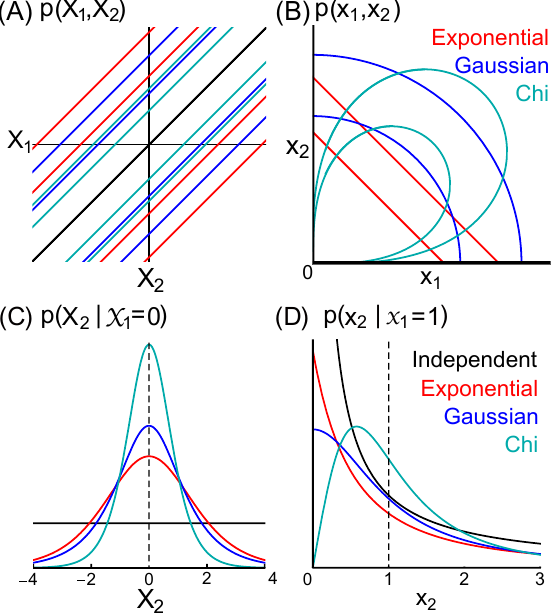
Figure 2. Exemplary distributions for exponential (red), Gaussian (blue), and chi (cyan) dependencies. ( A ) Equiprobability contours of p ( X 1 , X 2 ) , which we prove are parallel to the identity line for all dis- tributions in set S (Equation (29)). ( B ) Contours of p ( x 1 , x 2 ) . ( C ) Conditional distributions p ( X 2 | X 1 ) . This is uniform in the case of independence (black). The distributions given exponential and Gaussian dependence are the standard logistic (Equation (25)) and Cauchy distributions, respectively, with location parameter x 1 and scale parameter 1. ( D ) p ( x 2 | x 1 ) . This is 1/ x 2 in the case of independence (black). The exponential dependence results in the log-logistic distribution with scale parameter x 1 and shape parameter 1 (Equation